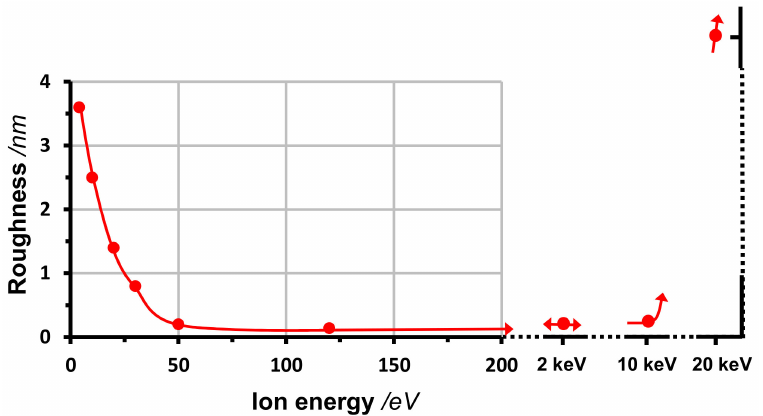
Figure 2. Roughness of carbon films, deposited by MSIBD at room temperature, in dependence on the ion energy. Film thickness about 100 nm (data from [45]).